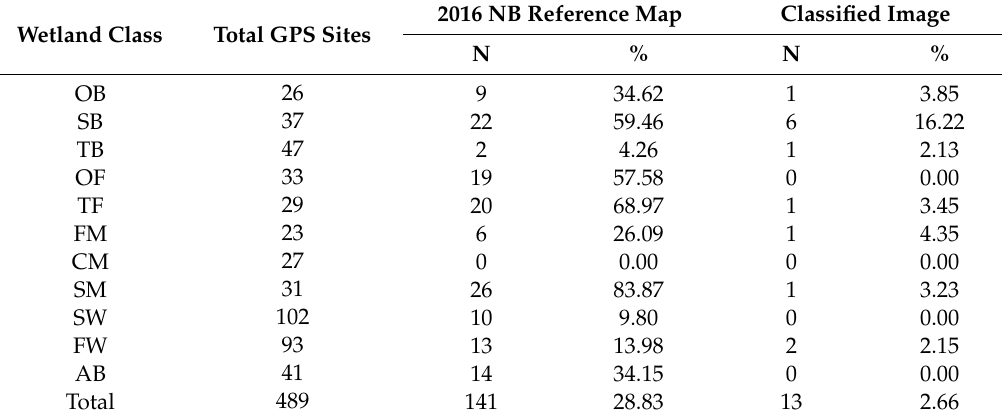
Table 16. Comparison between the 2016 NB reference map and the classified image for the number and percentage of the in-situ GPS wetland sites that were not identified in the right wetland class.